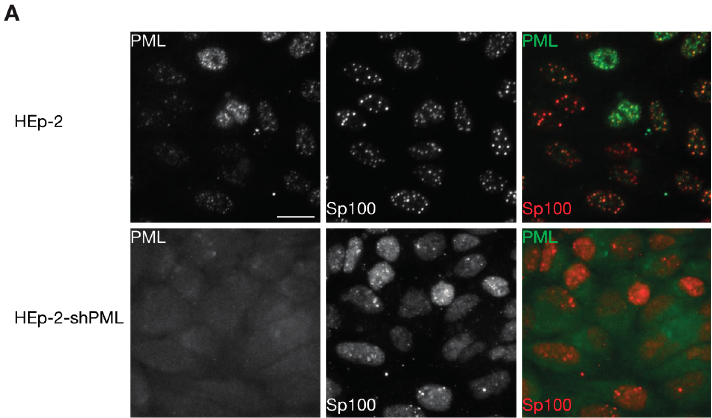
Figure 4. Mutation of PML phosphorylation sites results in minor changes in the SUMOylation state of PML-I. ( A ) HEp-2 cells and HEp-2 cells depleted of PML and stained with antibodies to detect PML and Sp100 by immunofluorescence. Scale bar = 10 μ m. ( B ) HEp-2-shPML cells were transfected with 900 ng of pGEM-3 (as carrier DNA) and 100 ng of a plasmid encoding FLAG-, eCFP-tagged PML-I or a mutant of PML-I. The next day,